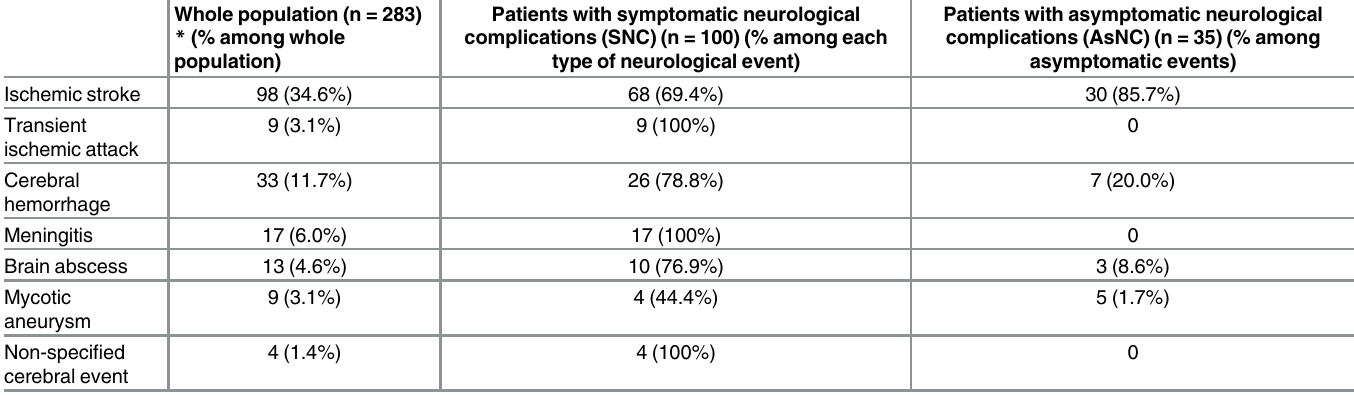
Table 2. Distribution of the different types of neurological complications among the whole population and among patients with symptomatic and asymptomatic neurological complications.